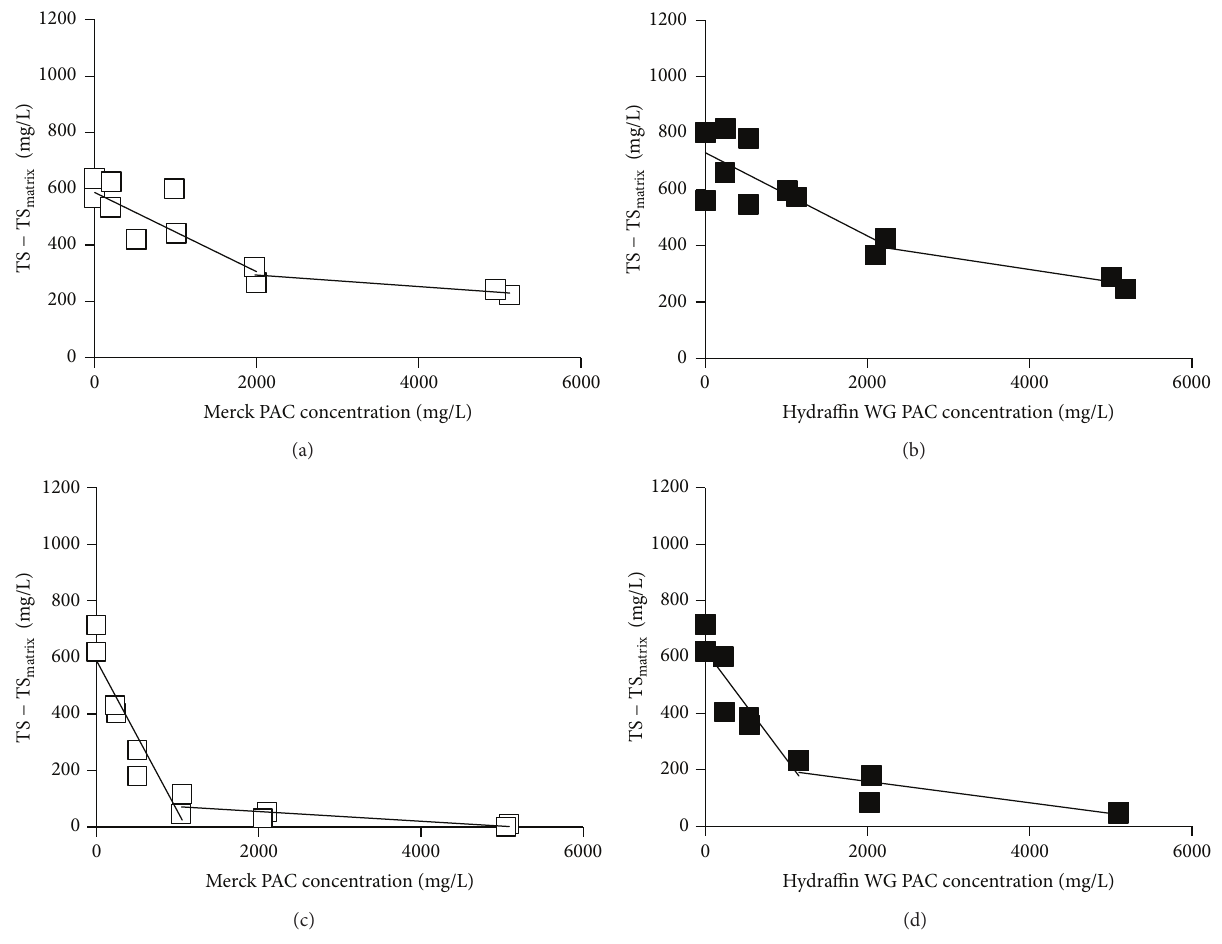
Figure6:Totalsolidsconcentrations(correctedforTSconcentrationsofthematrices)in1 g/LTiO 2 suspensionscontainingdifferentamounts of Merck PAC or Hydraffin WG PAC in a matrix of biologically pretreated greywater ((a), (b)) and secondary municipal effluent ((c), (d)) subsequent to vacuum filtration over spunbond polypropylene fabrics.